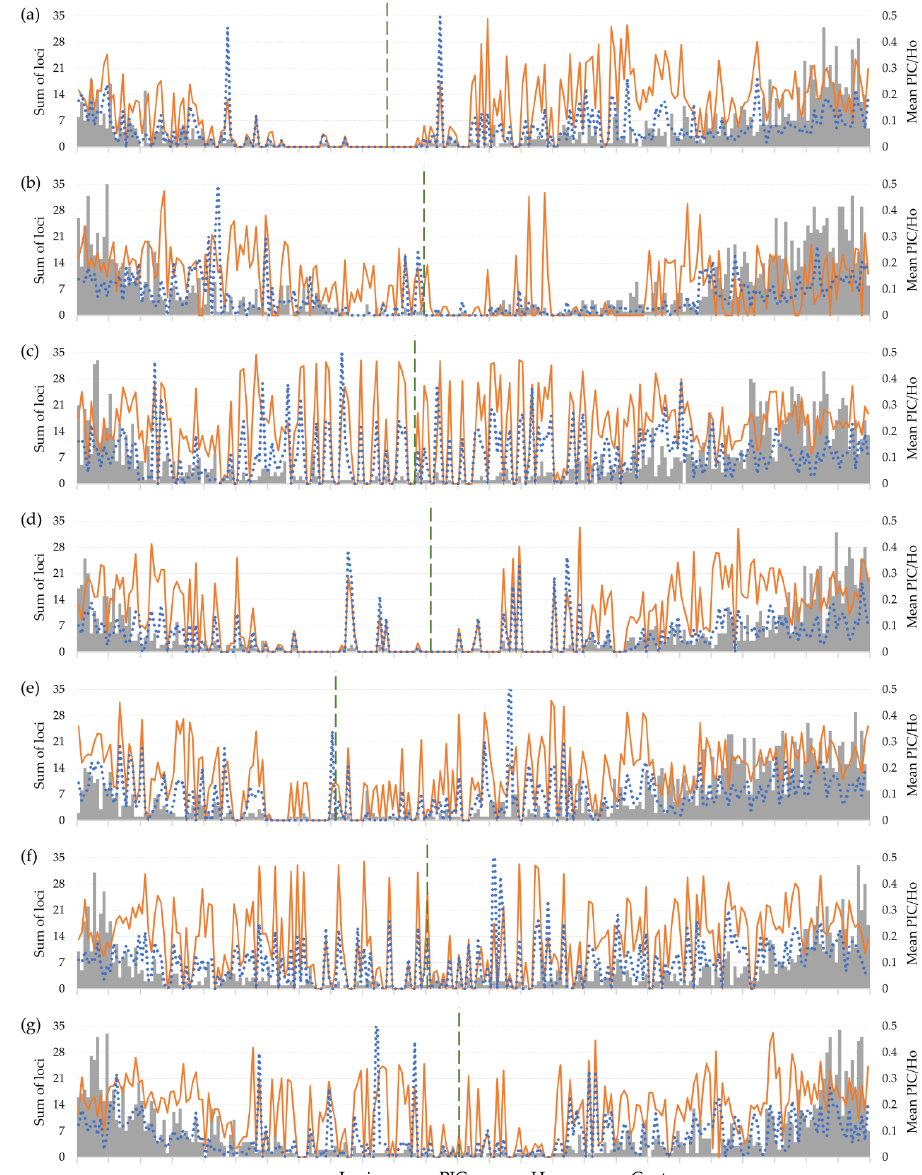
Figure 3. Frequency of analyzed loci and mean PIC and Ho values along chromosomes were assessed by a sliding window approach with 500 kb windows at 250 positions along the full length of barley chromosomes based on the genome assembly: IBSC_v2 [51] all chromosomes have been normalized to a standard length; ( a – g ) chromosome 1H—7H,